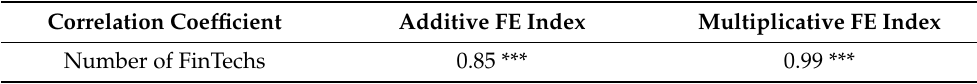
Table 6. Relation between FE attributes and productive entrepreneurship. Correlation Coefficient Additive FE Index Multiplicative FE Index Number of FinTechs 0.85 *** 0.99 *** Note: *** p < 0.001.